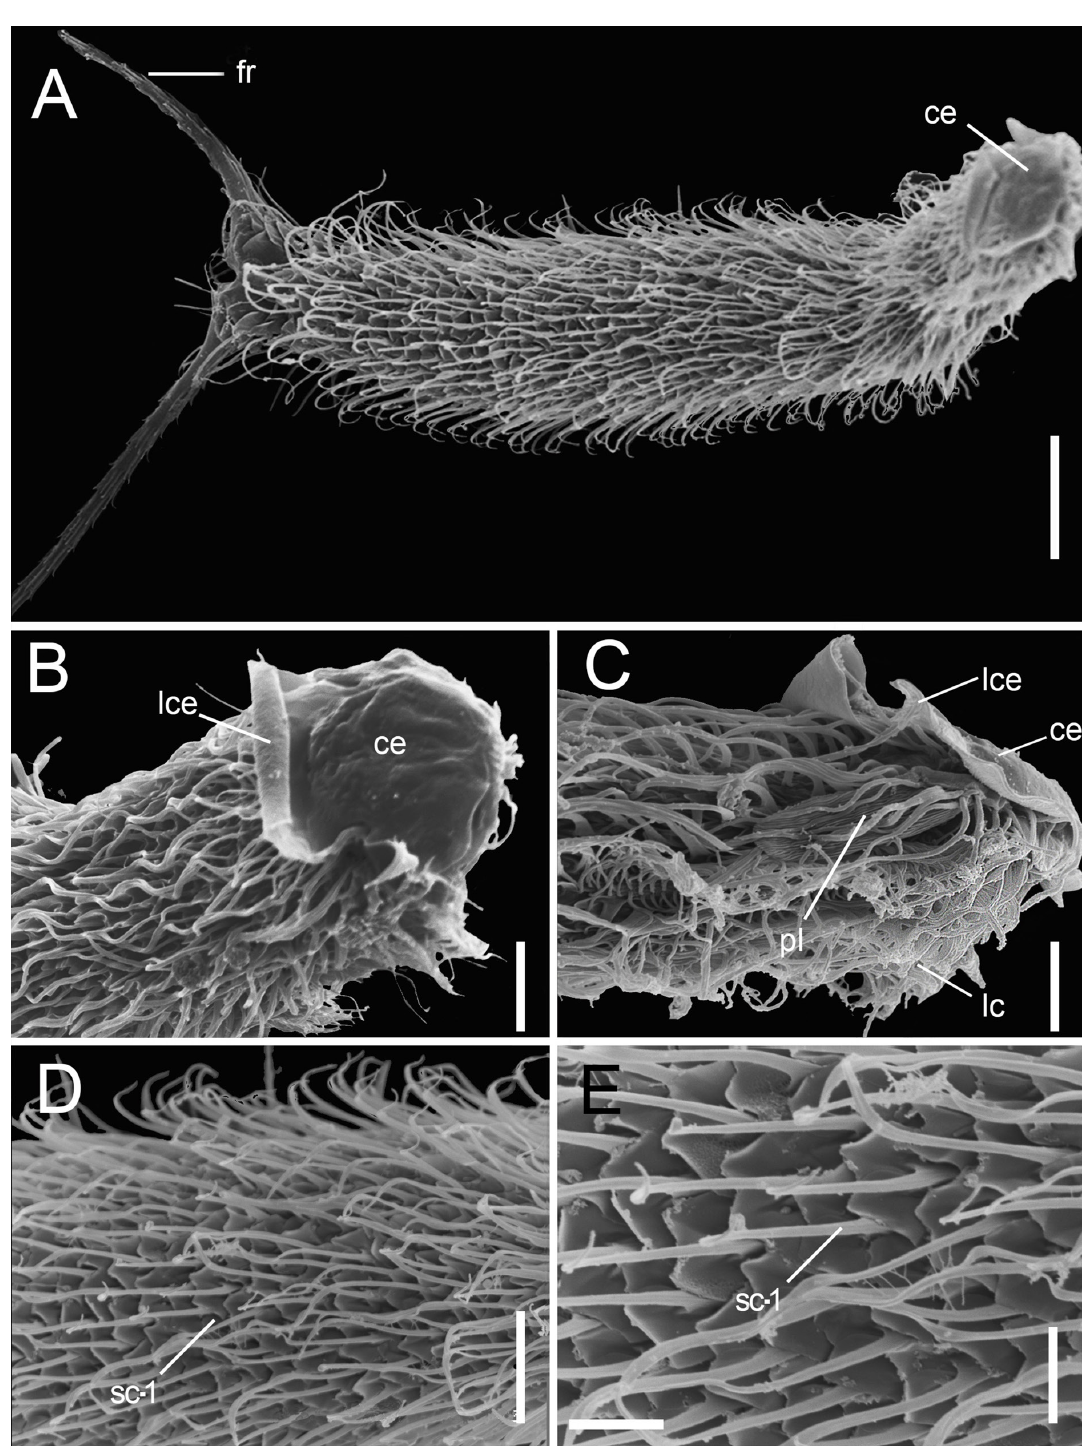
Fig. 7. Scanning electron microscopy. Polymerurus insularis sp. nov. A–B, D–E . Paratype (ZUEC GCH 59). C . Paratype (ZUEC GCH 60). A . Dorsal view of the body. B . Dorsolateral view of the head, showing the cephalion and its lateral projections. C . Lateral view of the head, highlighting the lateral pleurae. D–E . Dorsal trunk view, highlighting scale Type 1 . Abbreviations: ce = cephalion; fr = furcal rami; lc = locomotory cilia; lce = lateral cephalic expansions; pl = pleurae; sc-1 = Type 1 scales. Scale bars: A = 40 µm; B–C = 5 µm; D = 20 µm; E = 10